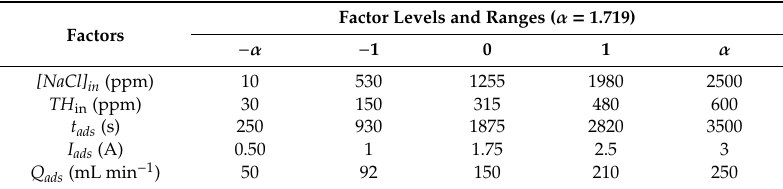
Table 1. Experimental design: factor levels and